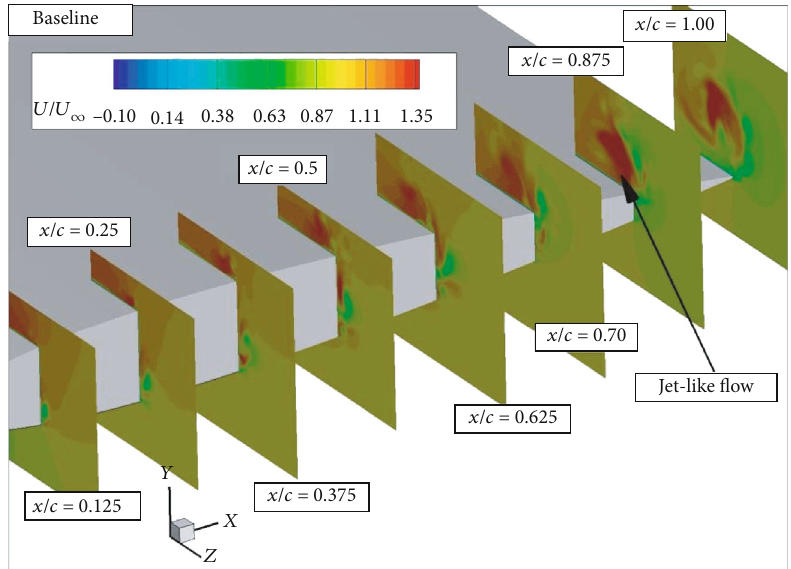
Figure 17: The axial velocity distribution of clean